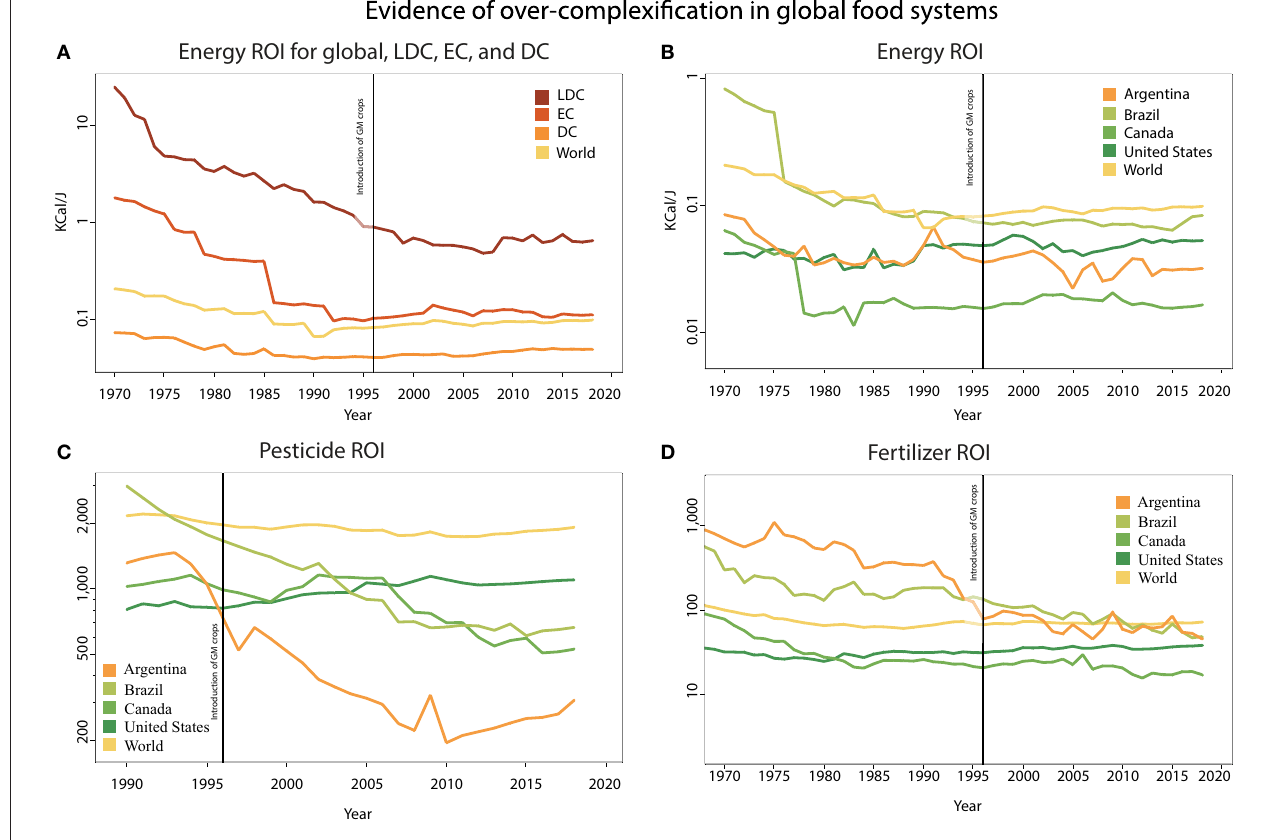
FIGURE 4 | Decreased return on investments in global agriculture. E-ROI for: (A) global and grouped by OECD categorization of developed countries (DC), emerging countries (EC), and least developed countries (LDC); (B) E-ROI for Argentina, Brazil, Canada, and United States; and, ROI for pesticide use (C) and fertilizer use (D) for Argentina, Brazil, Canada, and United States and globally. Data are plotted on a logarithmic scale to ensure comparability and account for the necessarily asymptotic nature of the data, so that the more dramatic patterns seen for LDCs and ECs do not dampen the trends found for DCs. Note there is no evidence of a change in ROI trends following the introduction of GM crops (vertical line at